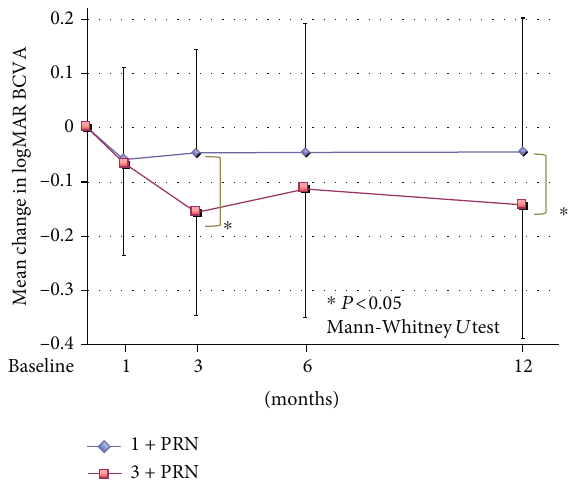
Figure 3: Changes in the mean BCVA (logMAR units) from the baseline to 12 months after the IVA. In the 3+PRN group, the mean BCVA was signi fi cantly improved at 3 and 12 months after the IVA compared to that in the 1+PRN group ( P = 0 : 0389 and 0.0183, respectively; Mann Whitney U test). BCVA: best-corrected visual acuity; PRN: pro re nata ; logMAR: logarithm of the minimum angle of resolution.